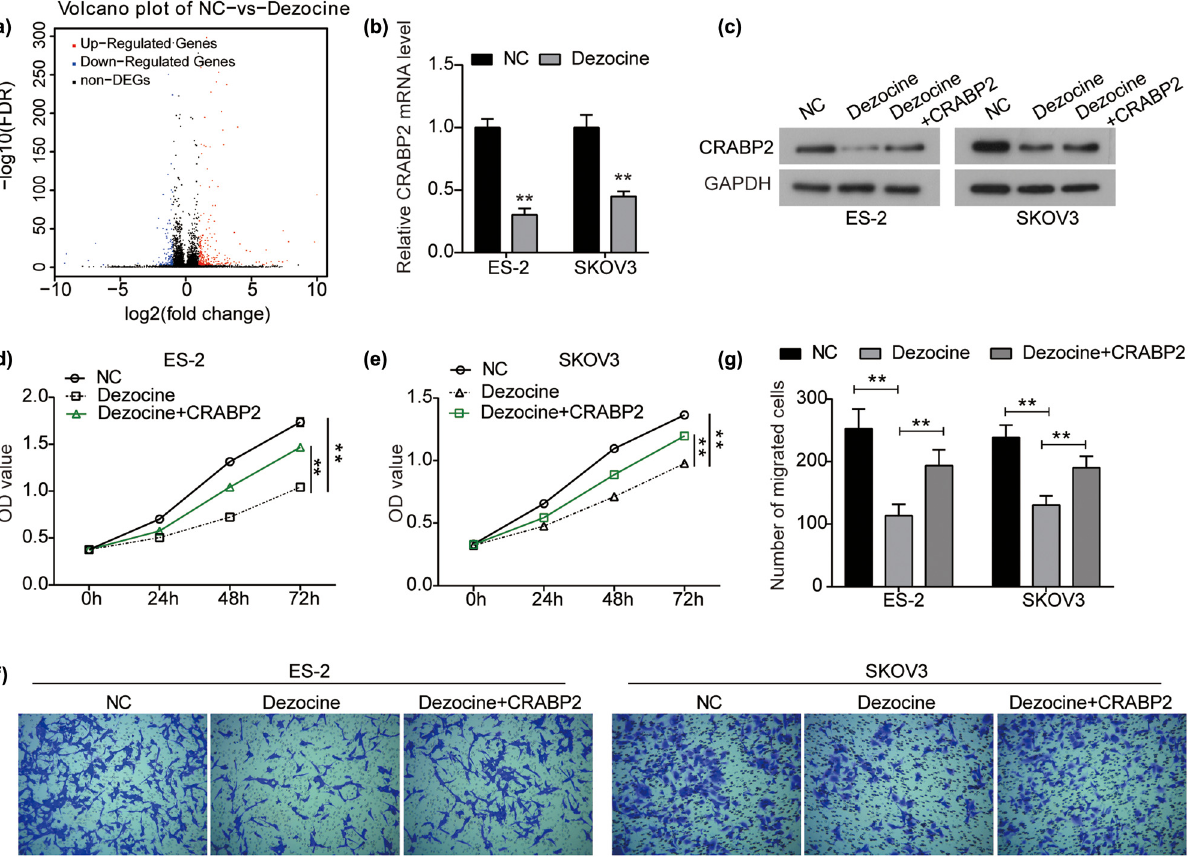
Figure 4: Dezocine inhibits the proliferation and migration of ovarian cancer by down - regulating CRABP2. ( a ) By RNA - Seq analysis, the DEGs (| log | > 1 & Q value < 0.001 ) in ES - 2 cells treated with dezocine. ( b ) Expression of CRABP2 mRNA was detected by RT - PCR 2 fold change analysis in ES - 2 and SKOV3 cells treated with dezocine. ( c ) Expression of CRABP2 protein was detected by western blot analysis in ES - 2 and SKOV3 cells treated with dezocine or dezocine + pcDNA3.1 - CRABP2. ( d and e ) ES - 2 ( d ) and SKOV3 ( e ) cells were treated with dezocine or dezocine + pcDNA3.1 - CRABP2, and cell viability was measured by CCK8 assay. ( f and g ) After indicated treatment, cell migration was measured by transwell assay. ** P <